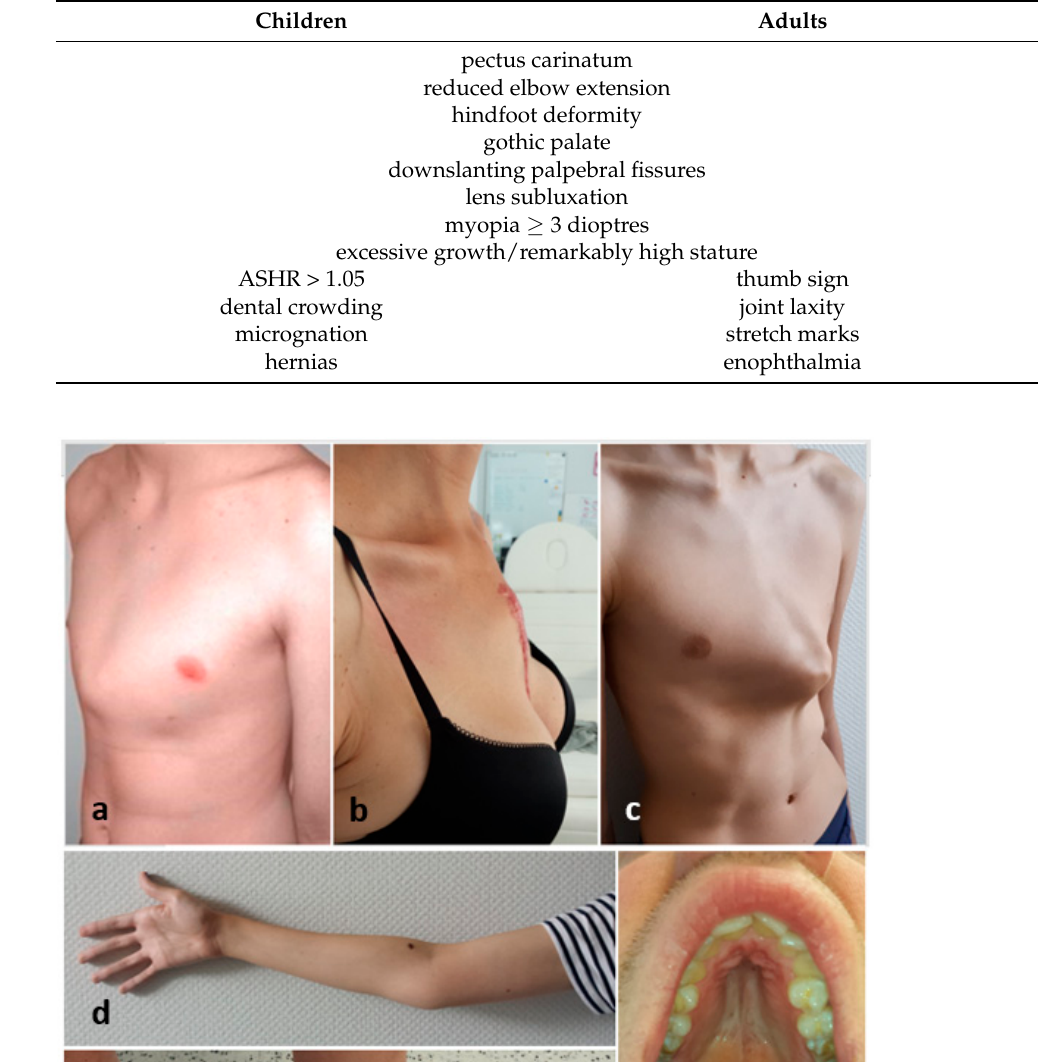
Table 4. Features that turned out to be useful for differentiating between Marfan syndrome and marfanoid habitus in children and adults should be seen as red flags in the context of Marfan syndrome suspicion.